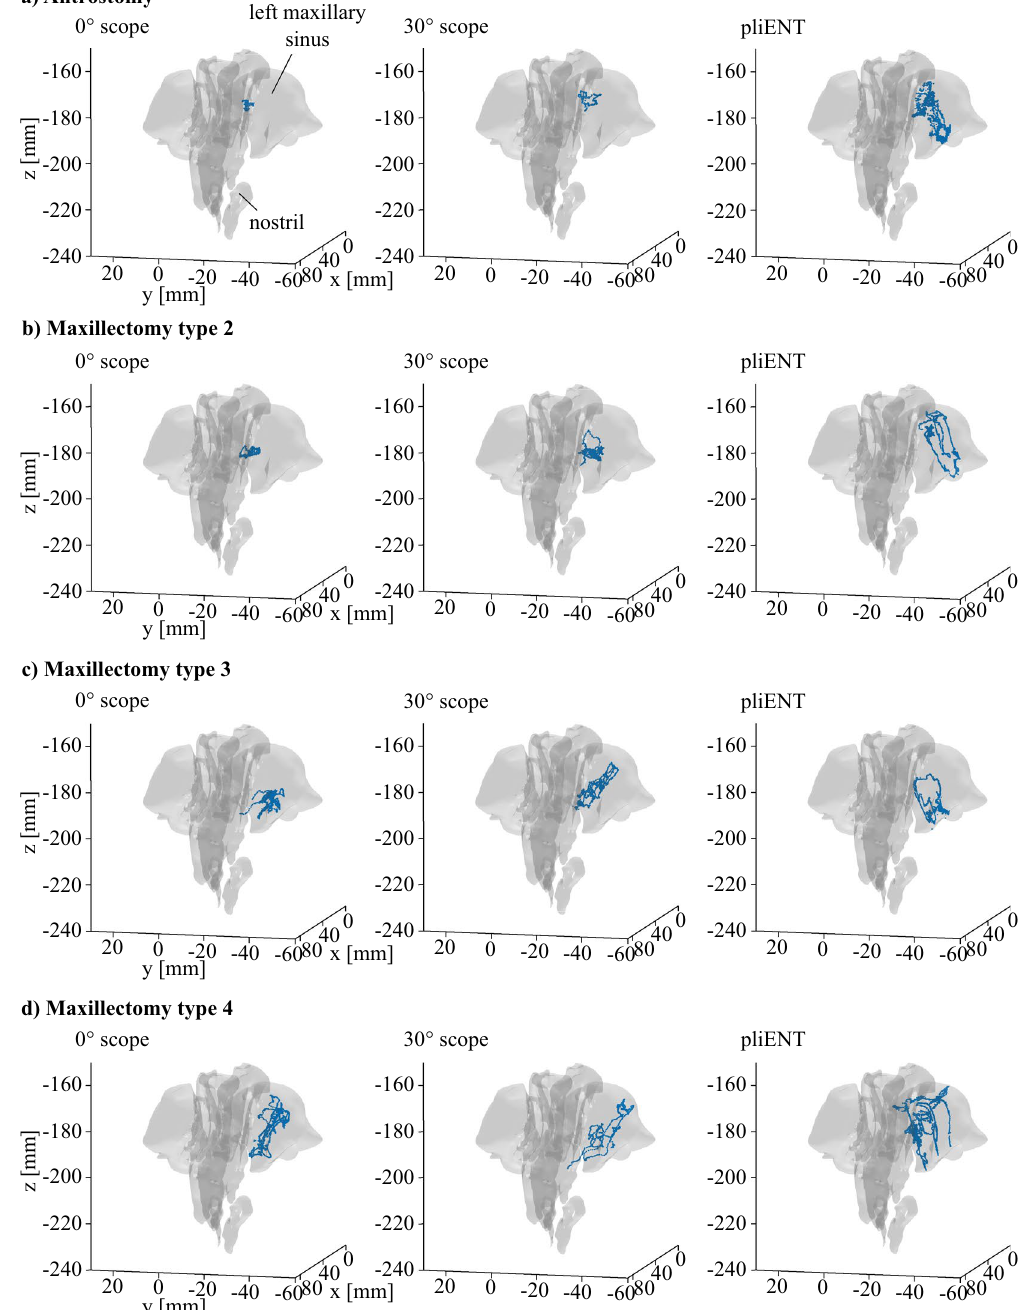
Figure 6. Instrument tip positions acquired by tracking of the EM sensor placed on the instruments’ tip. Tracking only takes place when the tip is inside the maxillary sinus. Each enlargement procedures is provided: ( a ) an antrotomy; ( b ) a maxillectomy type 2; ( c ) a maxillectomy type 3; ( d ) a maxillectomy type 4. Each view is a top view of the maxillary sinus and nasal cavity with the nostrils below and the posterior wall of the maxillary sinus